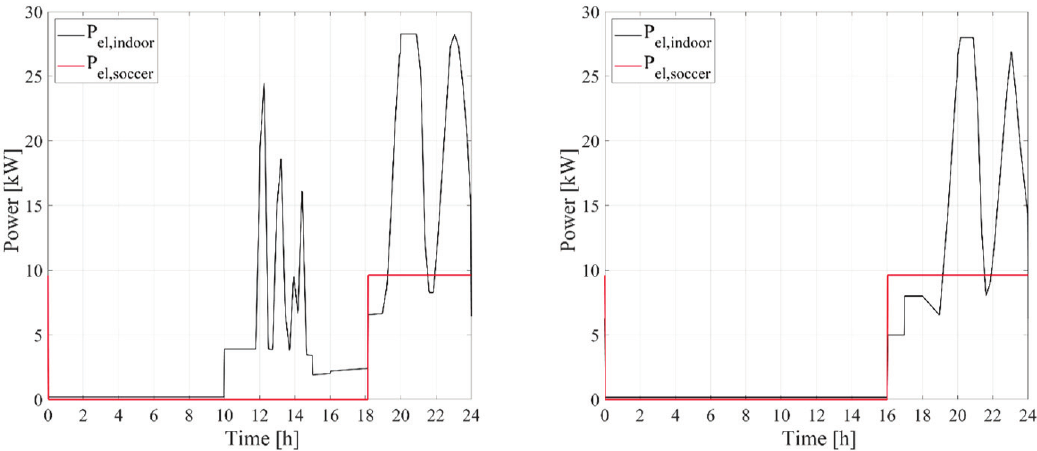
Figure 3. Daily electric load for a typical summer day ( left ) and for a typical winter day ( right ).